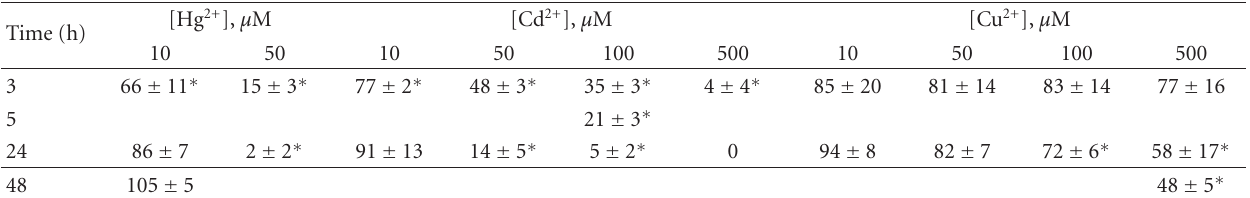
Table 3: Uncoupled respiration rates (%) of PC12 cells after di ff erent time of incubation with increasing concentration of Hg 2+ , Cd 2+ , or Cu 2+ .